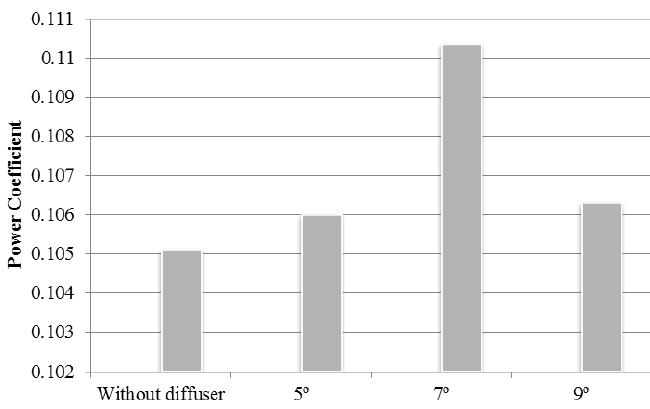
Figure 12. Power coefficient of different diffuser plate arrangements.